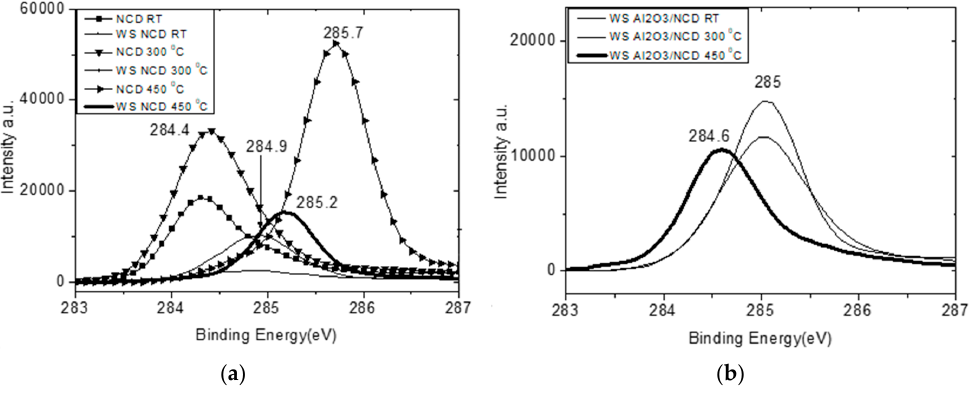
Figure 12. XPS spectra of the C 1s peak taken on the ( a ) NCD and ( b ) Al 2 O 3 /NCD films.